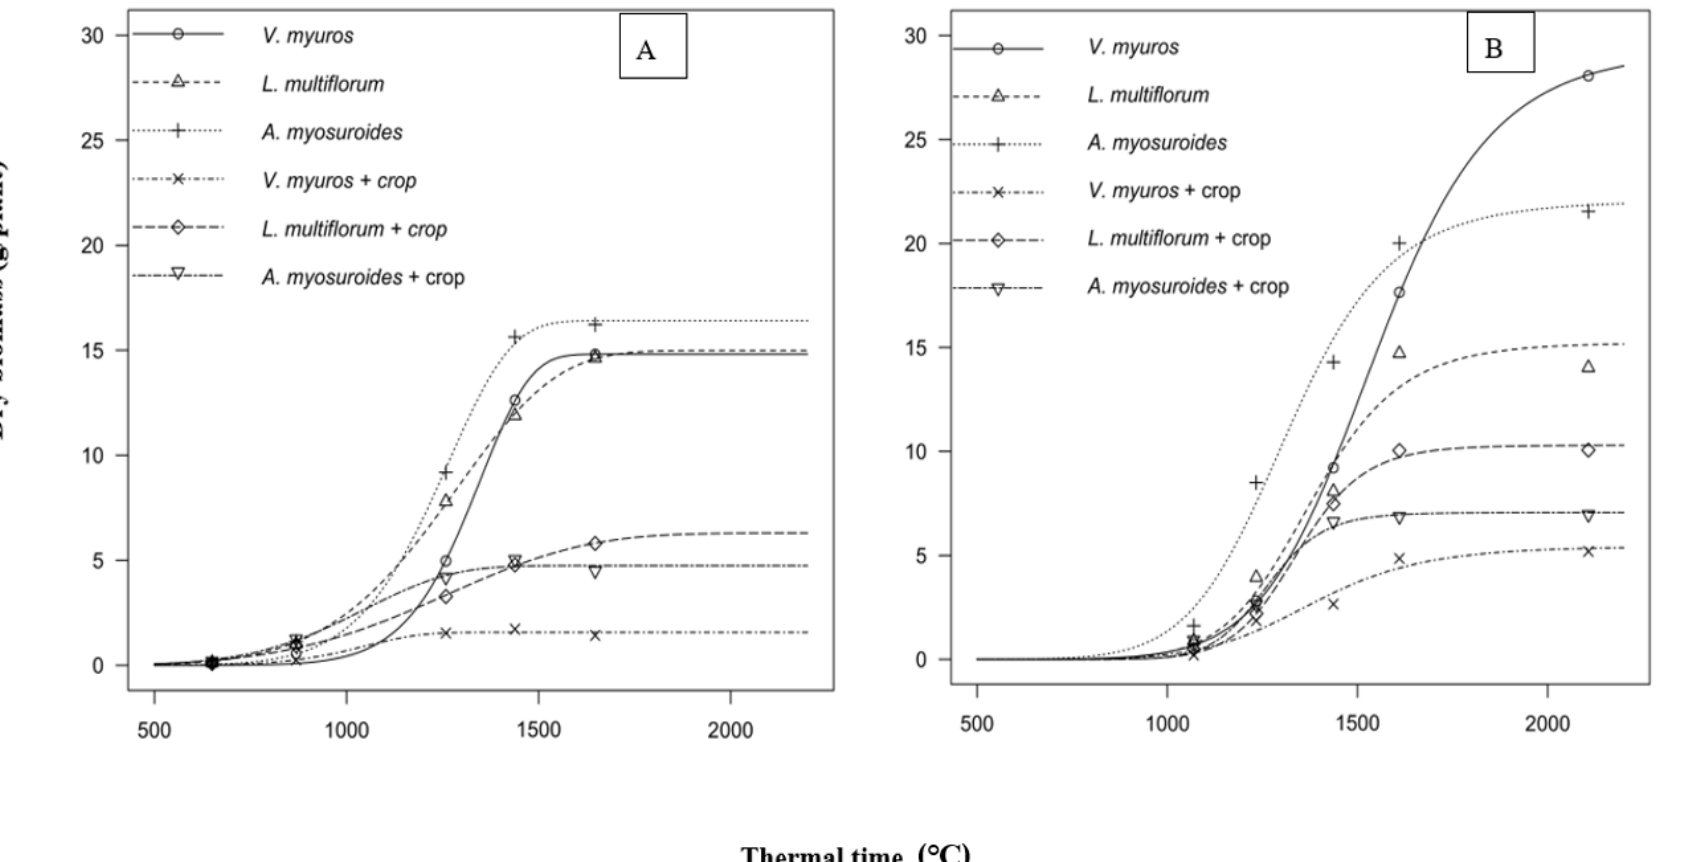
Figure 4. Per plant biomass accumulation of V. myuros , L. multiflorum and A. myosuroides grown in the absence and presence of winter wheat crop in relation to thermal time (°C) in 2017/18 ( A ) and 2018/19 ( B ). Regression equation and parameter estimates given in Table 2 (2017/18) and Table 3 (2018/19).